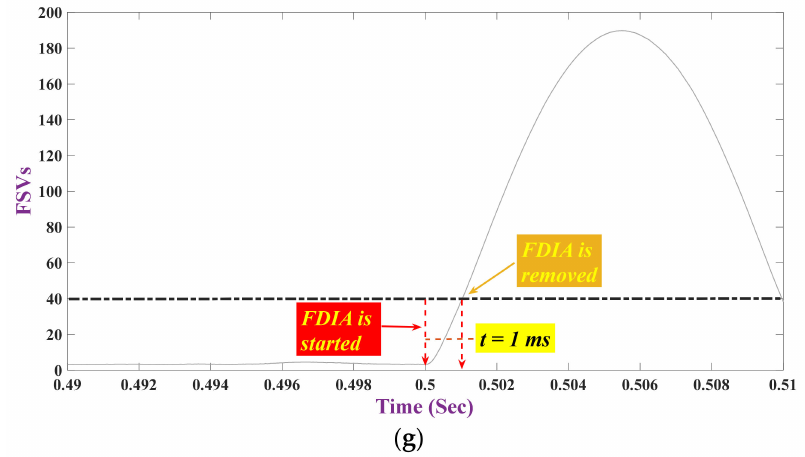
Figure 10. Instability stems from manipulating the load’s current reference waveform: Manipulating shared current between agent II and III: ( a ) ISMG’s voltage; ( b ) Loads current; ( c ) Current waveform of DG 1 ; ( d ) Current waveform of DG 2 ; ( e ) Current waveform of DG 3 ; ( f ) FSVs of signals; ( g ) Time response of FSV’s scheme (FDIA is initiated at t = 0.5 s and is omitted at t = 1